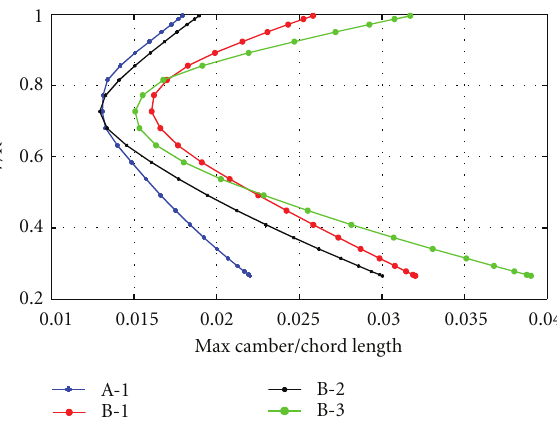
Figure 23: Camber/chord length, fore